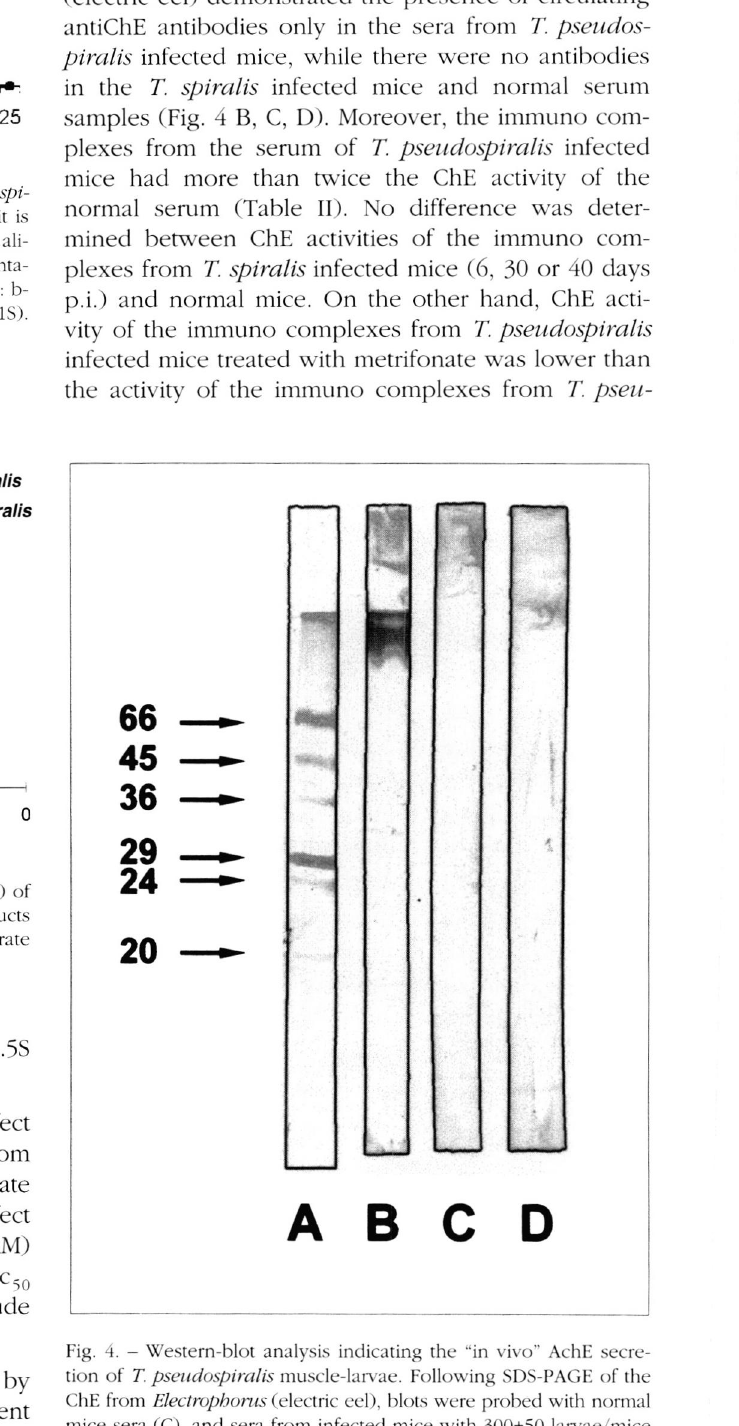
Fig. 4. - Western-blot analysis indicating the “in vivo” AchE secre­ tion of T. pseudospiralis muscle-larvae. Following SDS-PAGE of the ChE from Electrophorus (electric eel), blots were probed with normal mice sera (C), and sera from infected mice with 300±50 larvae/mice of T. spiralis (D) or T. pseudospiralis (B). Molecular-weight markers are shown on the figure